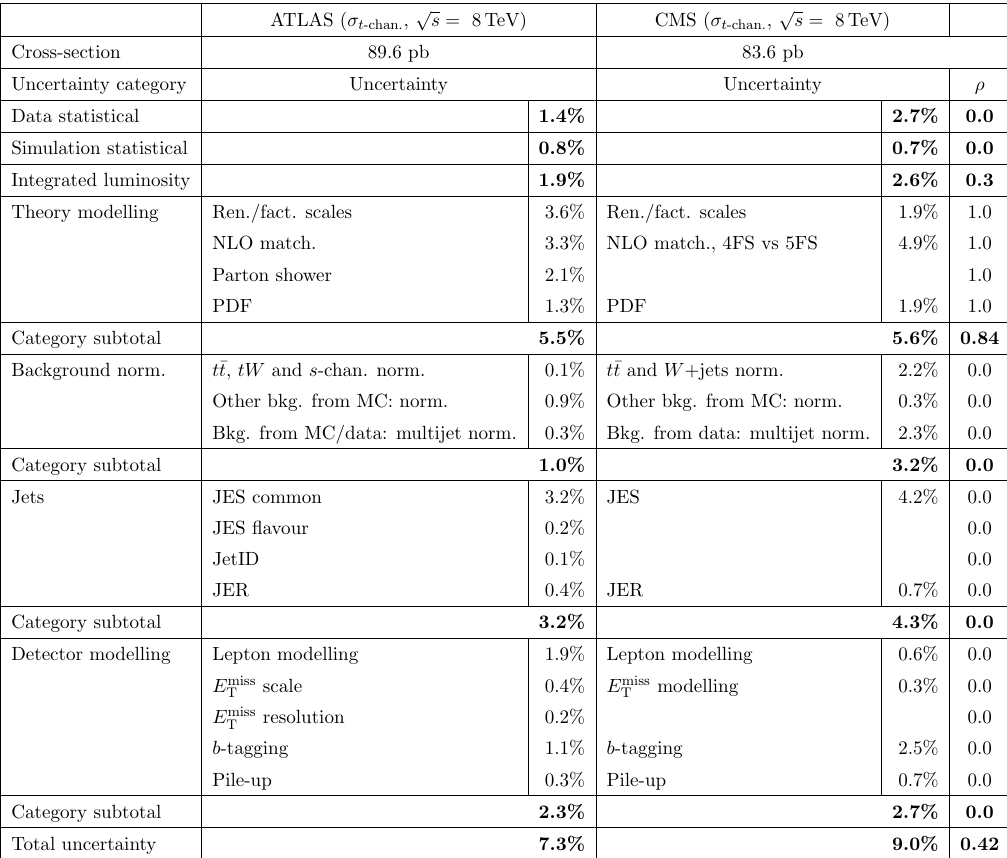
Table 10 . Measured cross-sections, uncertainty components, their magnitudes (relative to the indi- vidual measurements) and the correlation ( (cid:26) ) between the ATLAS and CMS (cid:27) t -chan. measurements at p s = 8 TeV. Uncertainties in the same row can be compared between experiments, as detailed in the text. The naming conventions follow those of the corresponding